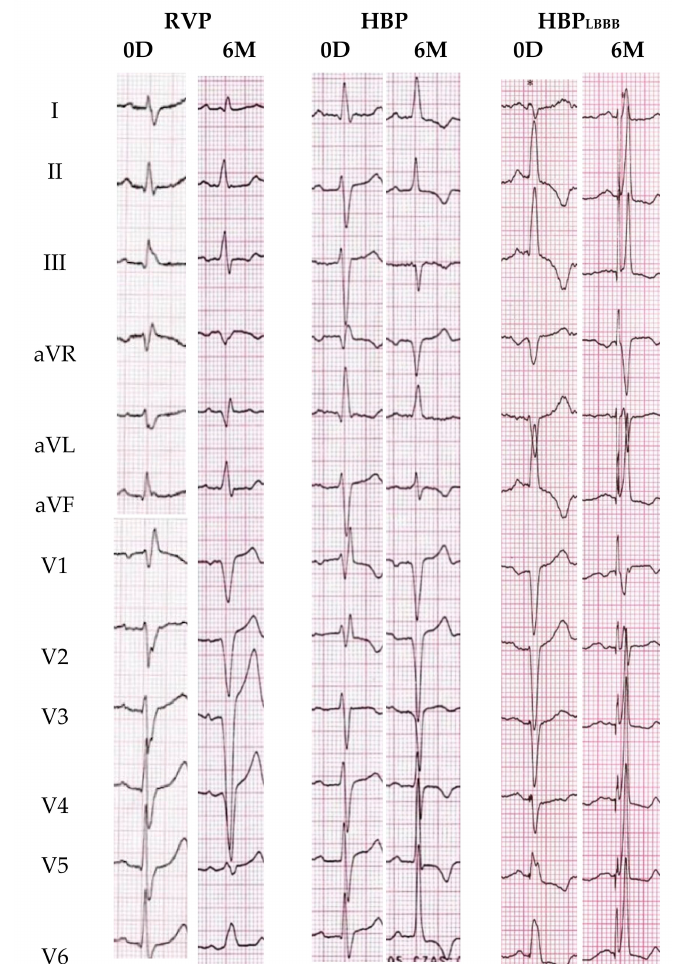
Figure 2. Comparison of 12-lead ECG recorded at a sweep speed of 25 mm/s before (0D) and 6 months after (6M) pacemaker implantation in selected patients treated with right ventricular pacing (RVP), His bundle pacing (HBP) and His bundle pacing in patients with pre-existing LBBB (HBP LBBB